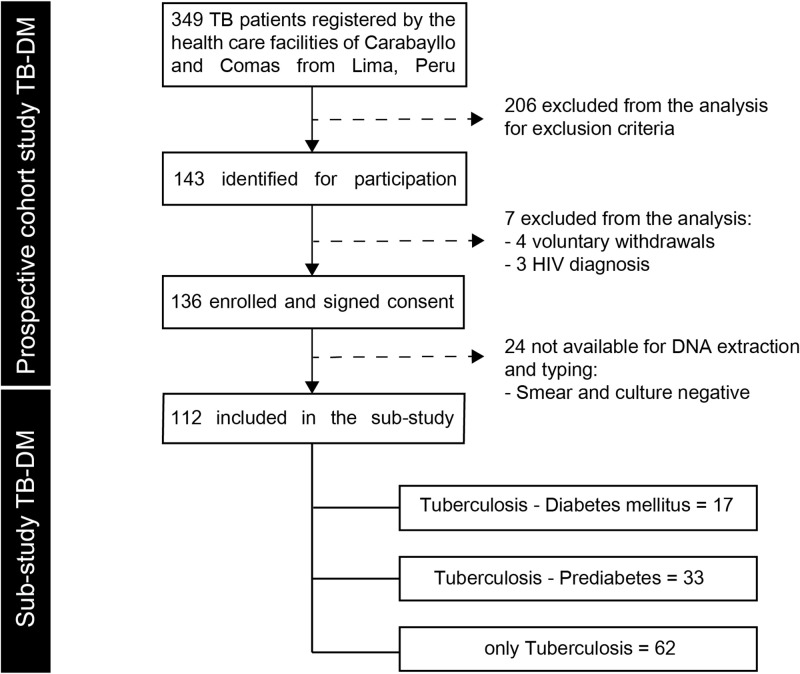
Flowchart of the study population.TB: pulmonary tuberculosis, DM: diabetes mellitus, PDM: prediabetes.